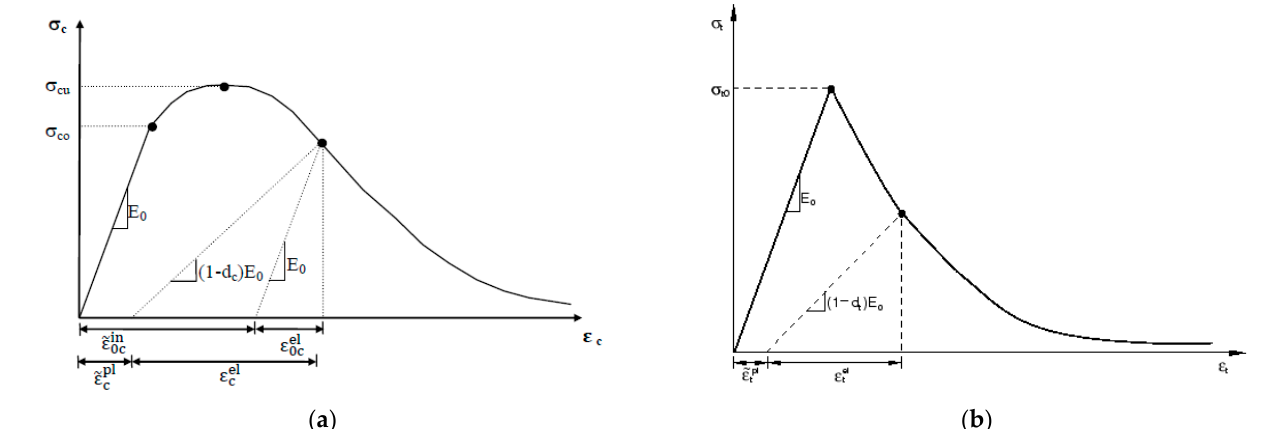
Figure 2. Response of concrete to uniaxial loading [38]: ( a ) response of concrete in compression; ( b ) response of concrete in tension.